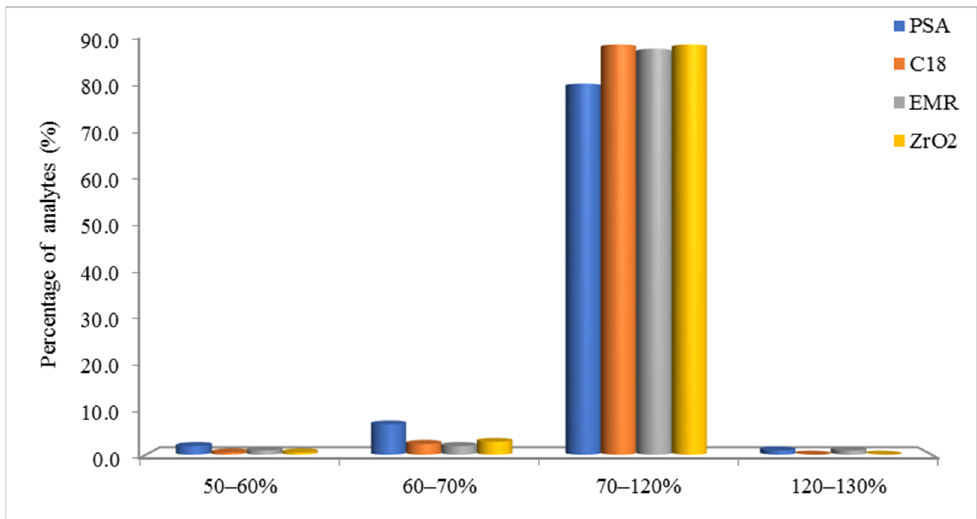
Figure 3. Comparison of recovery by different absorbents.